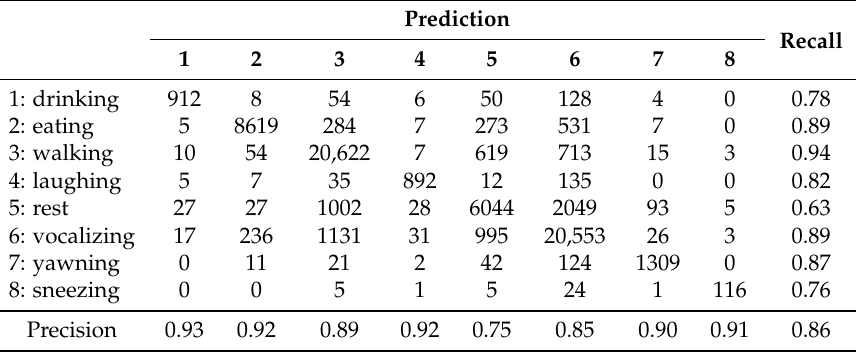
Table 5. Confusion matrix for eight